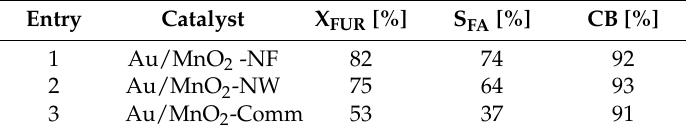
Table 3. Recycling tests. P = 12 bar (air), T = 110 ◦ C, reaction time 2 h, furfural:Au molar ratio = 100:1. Entry